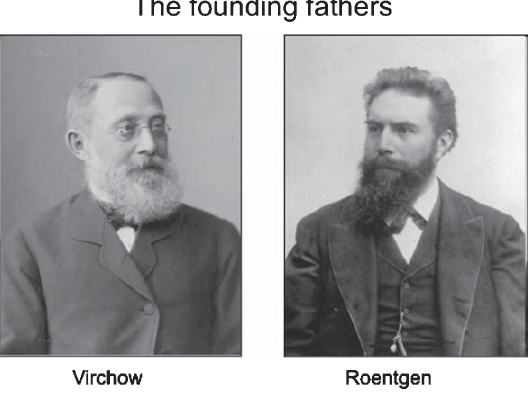
Fig. 3. Rudolf Virchow (1821–1902) and Wilhelm Roentgen